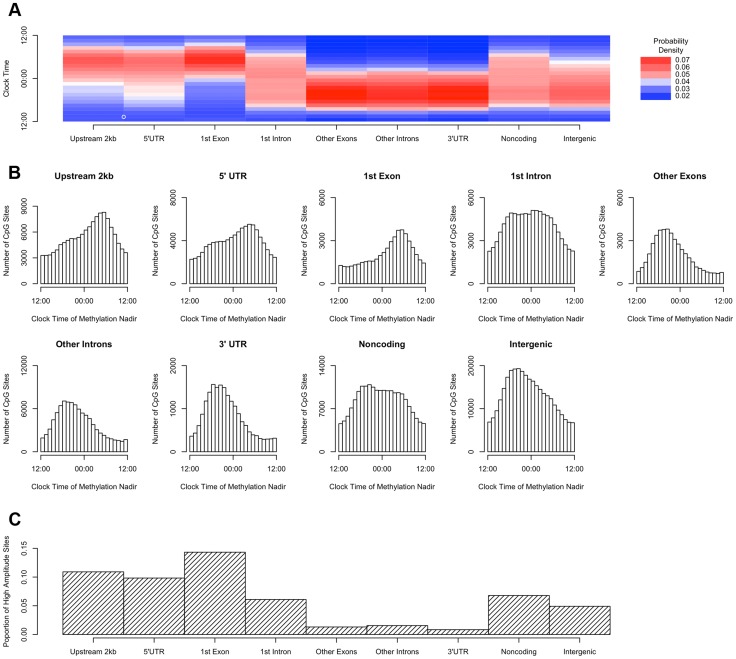
Sites in gene regions proximate to the transcription start site have a phase and amplitude distinct from other gene regions.(A) Heat map of the distribution of methylation nadir times for DNA methylation sties in various gene regions, considering all GENCODE v14 transcripts. (B) The same data expressed as histograms. Sites in the 2 kb upstream of the nearest transcription start site and in the 5′UTR, 1st exon, and 1st intron are most likely to reach their methylation nadir in the early morning, while those in other exons/introns, the 3′UTR, noncoding transcripts, and intergenic regions are most likely to peak in the evening (H1 = 14683.8; p<2.2×10-16 by the Rao Test for equality of polar direction). (C) The proportion of DNA methylation sites with high amplitude (peak to trough difference of>10% of the mean methylation level) in each gene region. The 2 kb upstream of the TSS, the 5′UTR, and the 1st exon are relatively enriched in sites with high amplitude oscillations (χ2 51250.8, p<2.2×10−16).